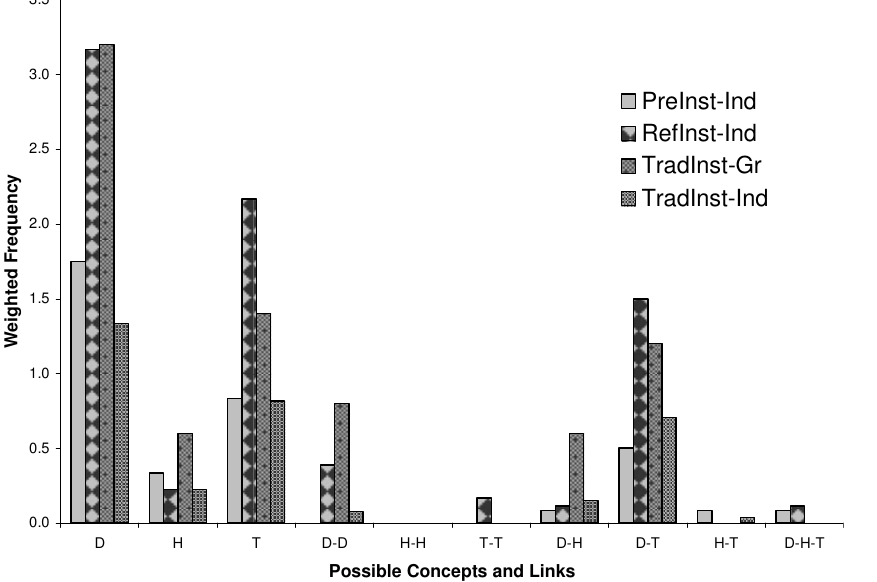
FIG. 4. Weighted data from